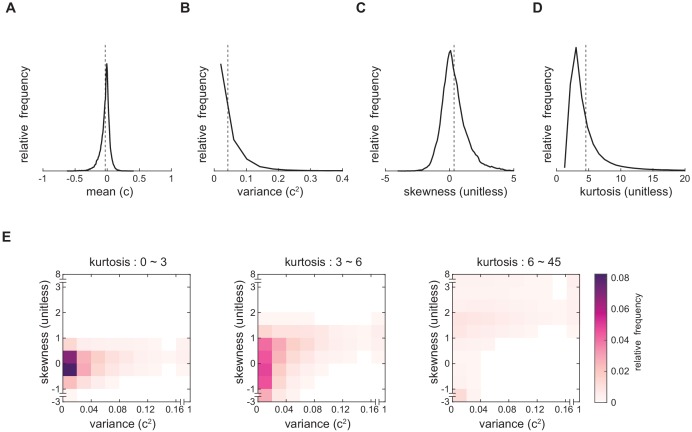
Natural scenes have heterogenous contrast statistics.(A-D) Distribution of the contrast mean, variance, skewness and kurtosis of individual images within the entire natural scene ensemble. Mean is denoted by the vertical dashed line. (B) Image statistics are correlated with each other. Joint-density maps of variance and skewness with different ranges of kurtosis.